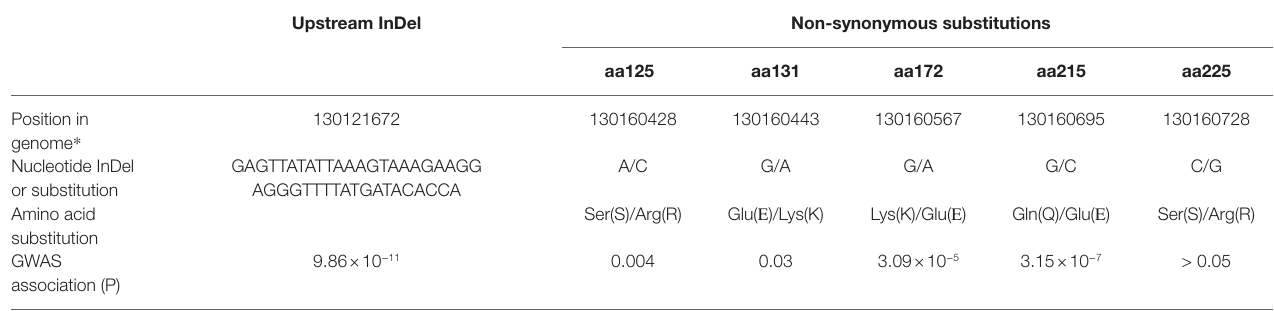
TABLE 5 | InDel in the promoter of CaOFP20 and non-synonymous substitutions in its coding region, and their significance level for fruit shape categories in the association panel. Upstream InDel